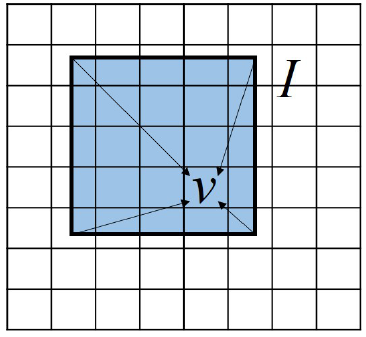
Figure 4. Schematic illustration of the one-way coupling method, taking a 2D case as an example, where the temperature of the finer CA cell ν is interpolated from the coarser FVM